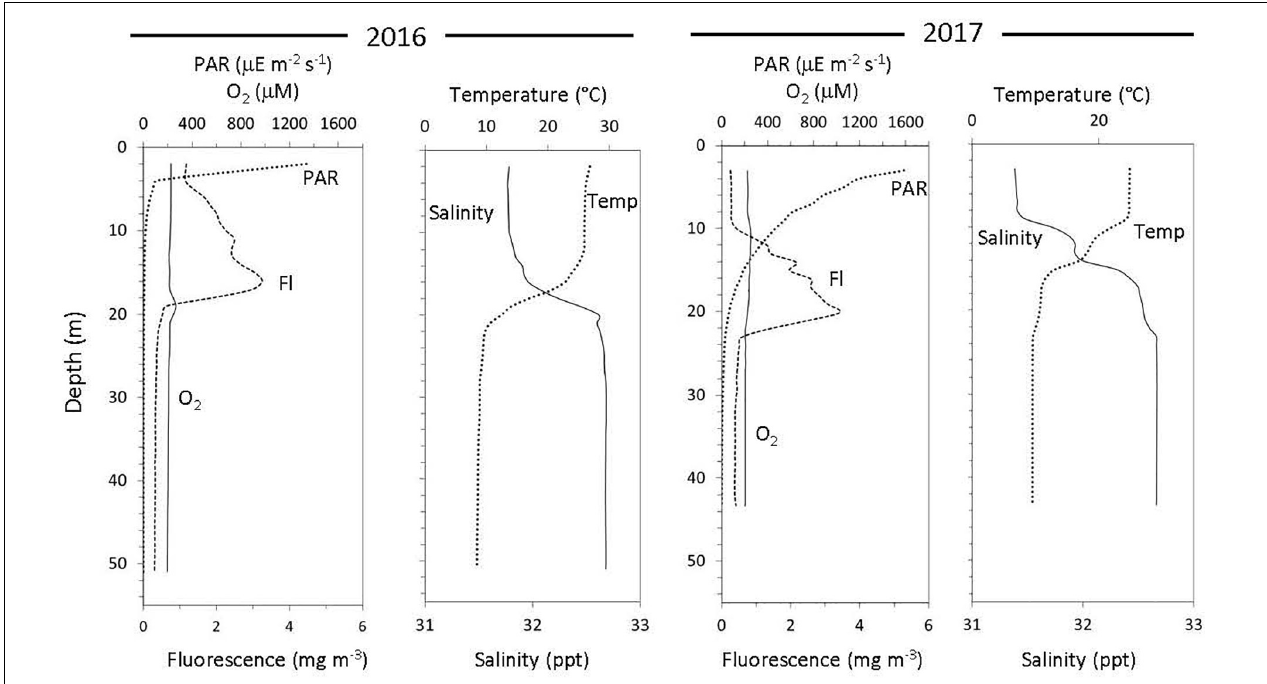
FIGURE 1 | Water column physicochemical properties over 2 consecutive years at the same location off the coast of New